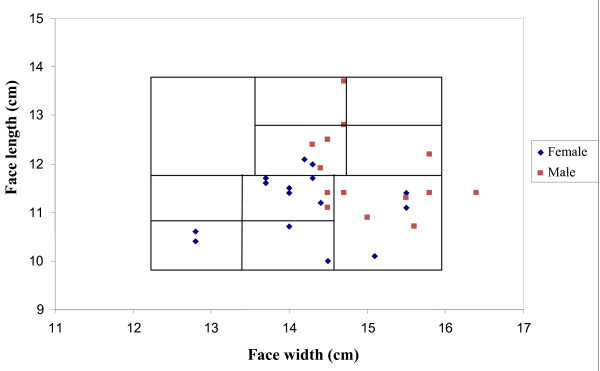
Scatter plot of South African participants against the improved NIOSH respirator fit test panel (RFTP) [7].